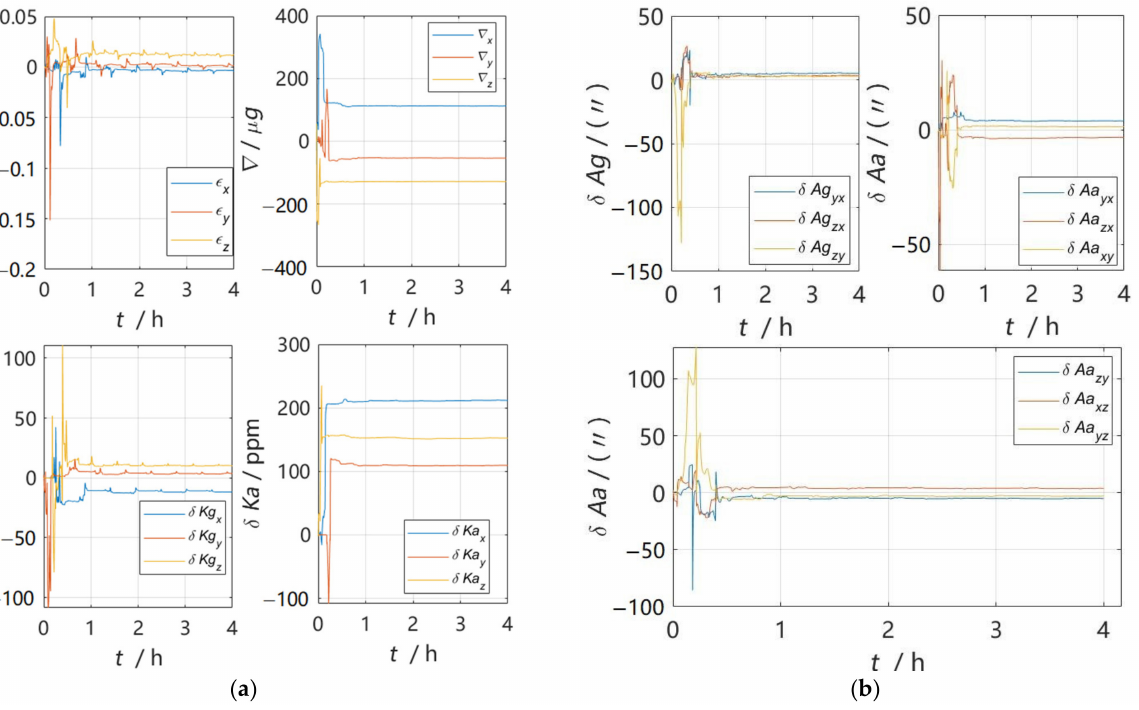
Figure 4. Error parameter estimation curve. ( a ) Constant error and scale factor error estima- tion curve of gyroscope and accelerometer; ( b ) installation error estimation curve of gyroscope and